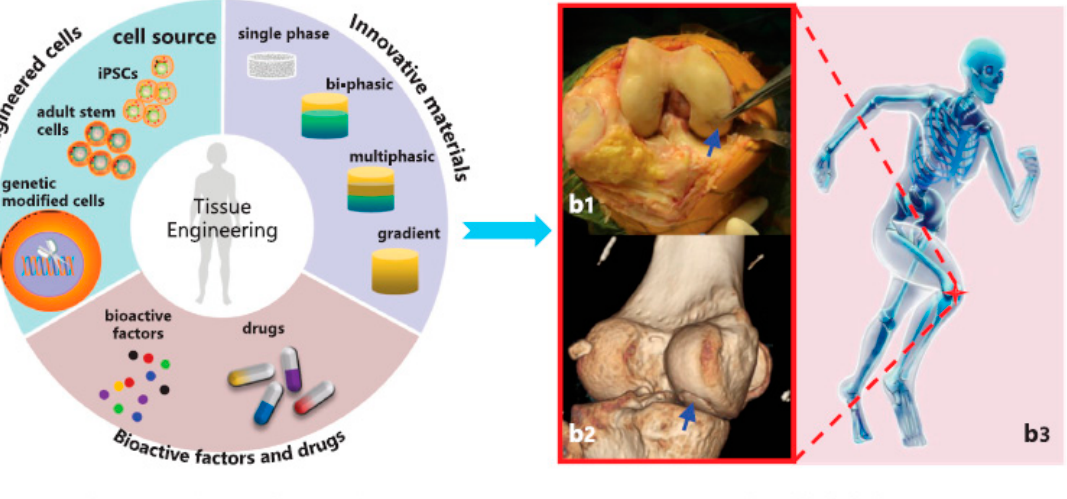
Figure 5. The building blocks of an OC tissue-engineered construct. OCTE strategies usually resort to the combination of innovative biomaterials, cells (e.g., primary or stem cells), and physiologically relevant bioactive molecules or drugs, aiming to recapitulate the biological, physical, and functional features of the native OC unit. Such biomimicking constructs can then be implanted into a damaged OC region, where they will assist tissue repair, promote regenerative responses, and facilitate the functional recovery of the joint. Reprinted from [243] with permission from Wiley Online Library. Copyright